Question: Identify the chart type used in this figure.
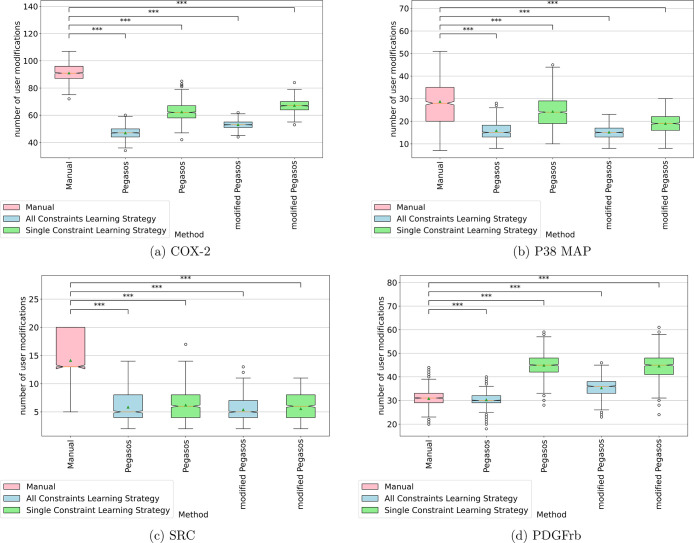
Answer: box